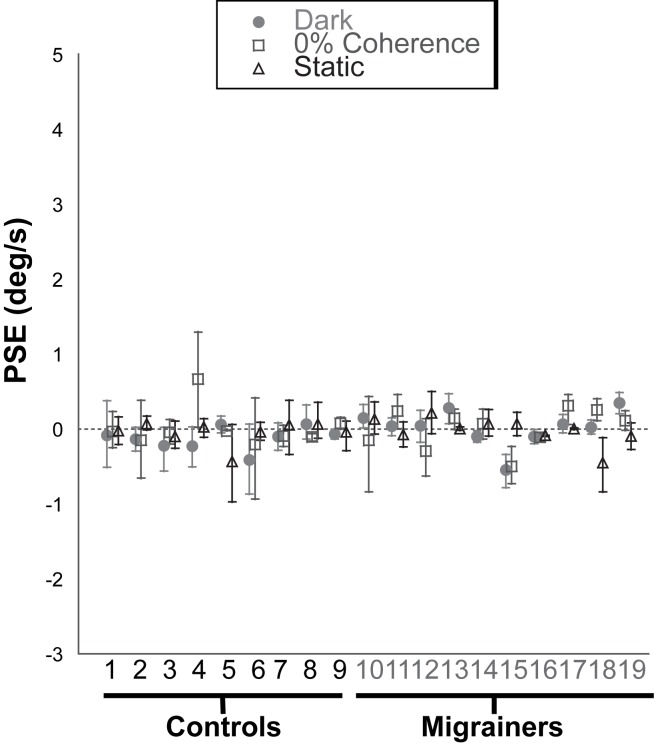
Individual Subject Data for Control Trials.Platform motion in darkness is demarcated by filled circles, platform motion with a 0% coherence visual stimulus is shown with open squares, and platform motion with a static visual stimulus is shown with triangles. Error bars represent 95% confidence intervals. The y axis limits were set to be consistent with Fig 3.